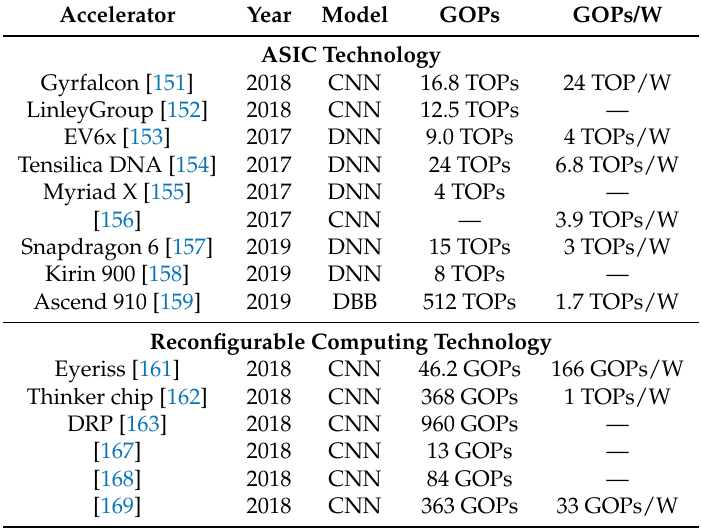
Table 5. Summary of hardware accelerators for deep learning on the